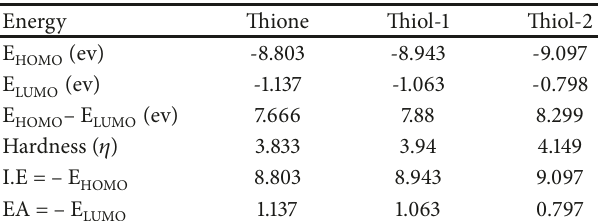
Table 2: FMO analysis of H4FPT.